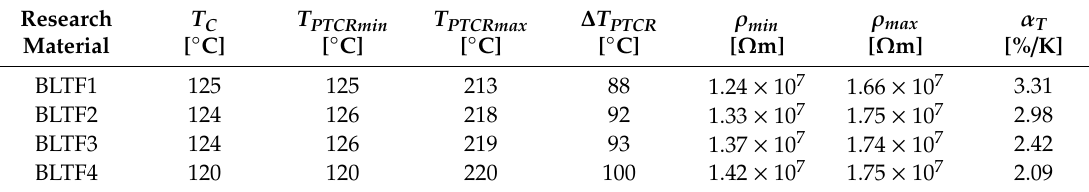
Table 3. Values of posistor parameters of BLTF ceramics.